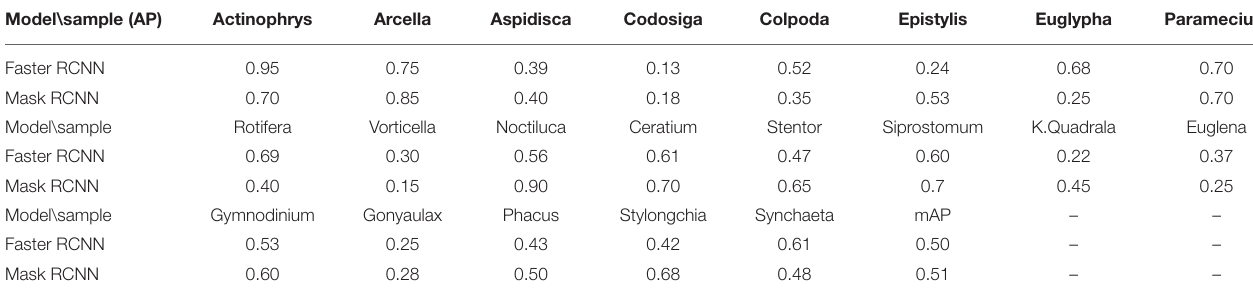
TABLE 12 | AP and mAP based on EMDS-6 object detection of different types of